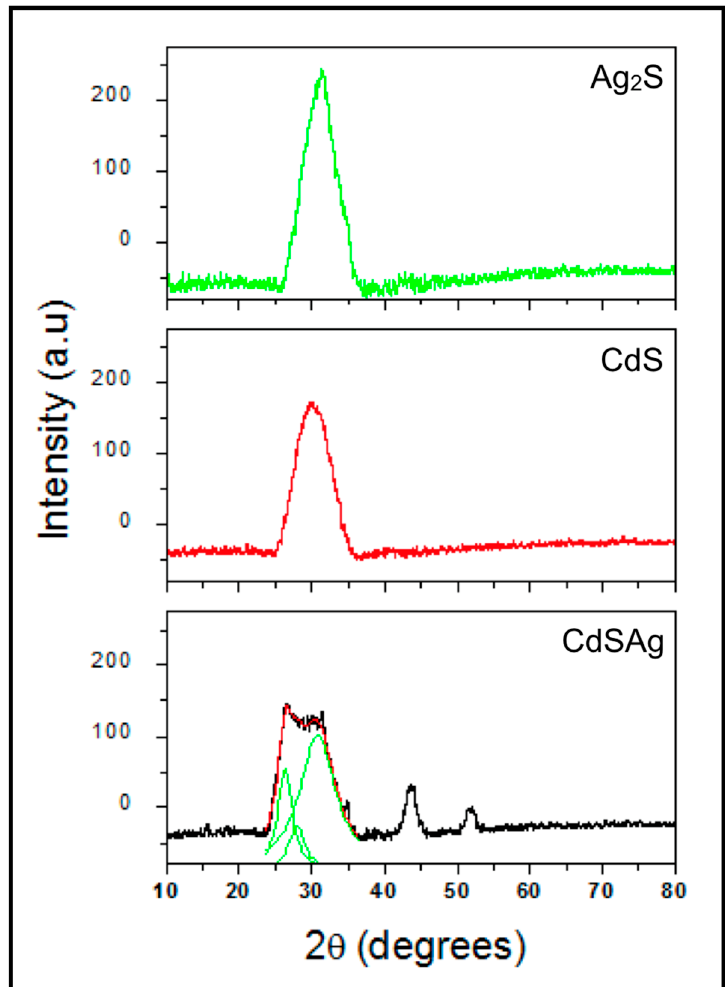
Figure 3. X-ray diffractograms of nanoparticles biosynthesized by E. coli , for Ag 2 S, CdS and CdSAg purified nanoparticles.